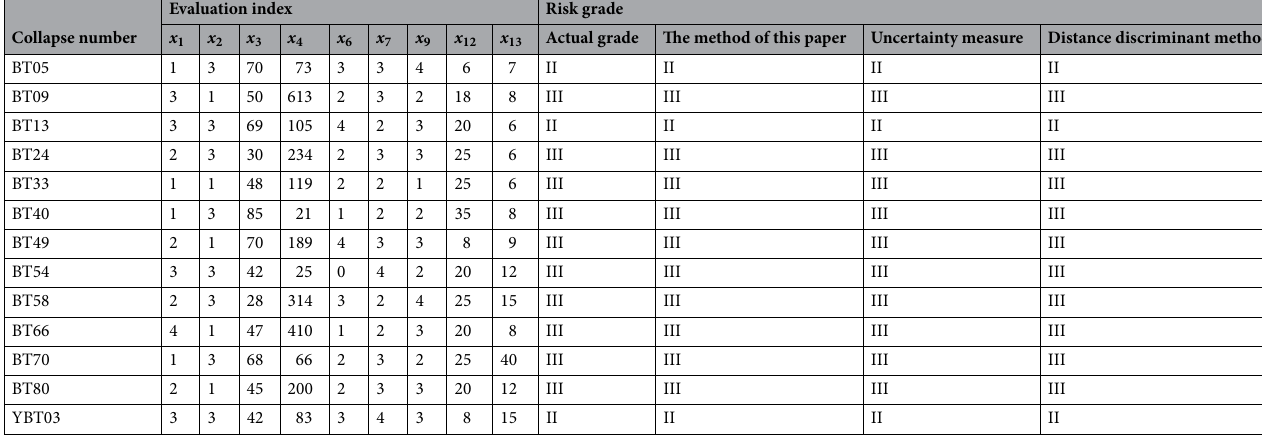
Table 4. Training samples of RS-SVM